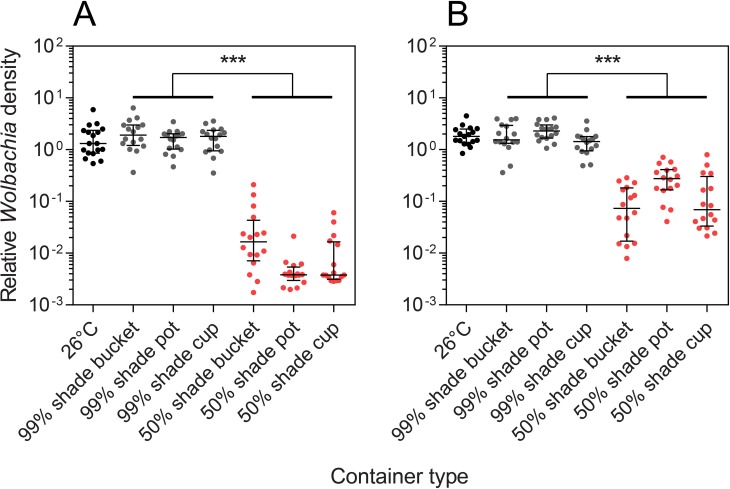
Wolbachia density of (A) Females and (B) males reared in different container types at two levels of shade in the first field experiment. All error bars are medians with interquartile ranges. *** P < 0.001 by Kruskal-Wallis test.